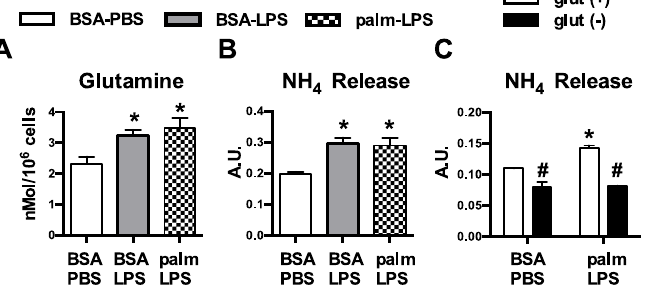
Figure 1. Glutamine metabolism is increased in activated macrophages. ( A ) Peritoneal